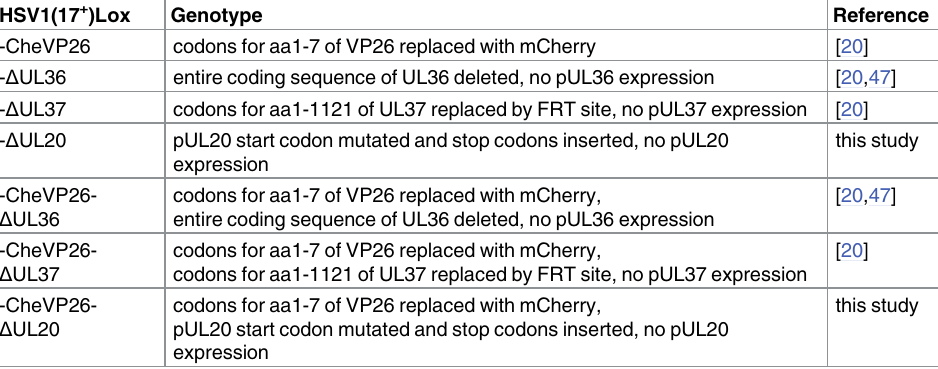
Table 1. HSV1(17 + )Lox strains used in this